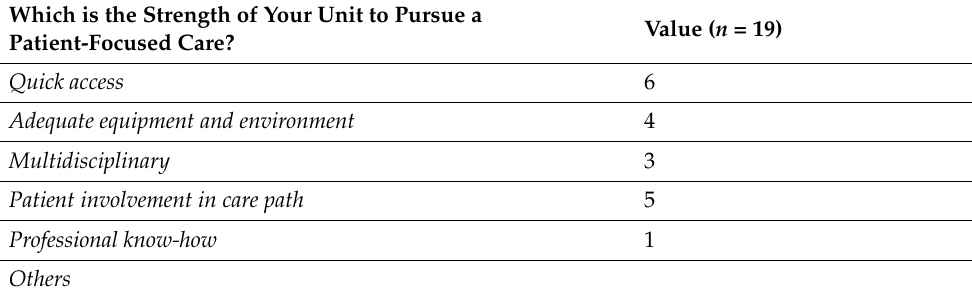
Table 2. Distribution of the responses to question seven provided by the clinicians, oncologists, and radiotherapists involved in the online survey.